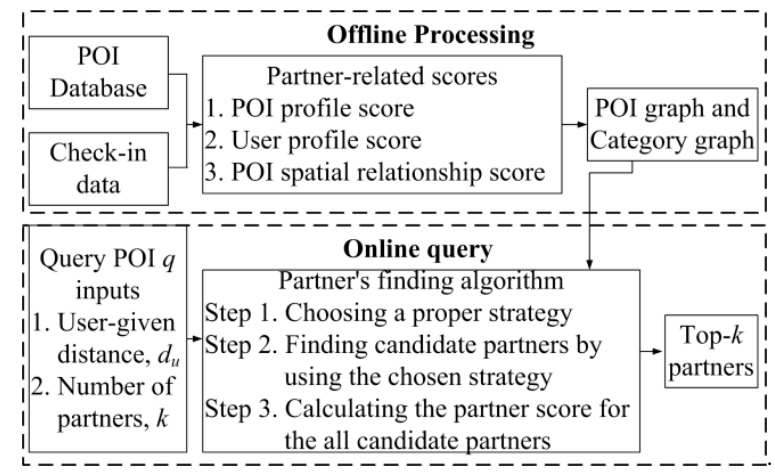
Figure 2. System framework.